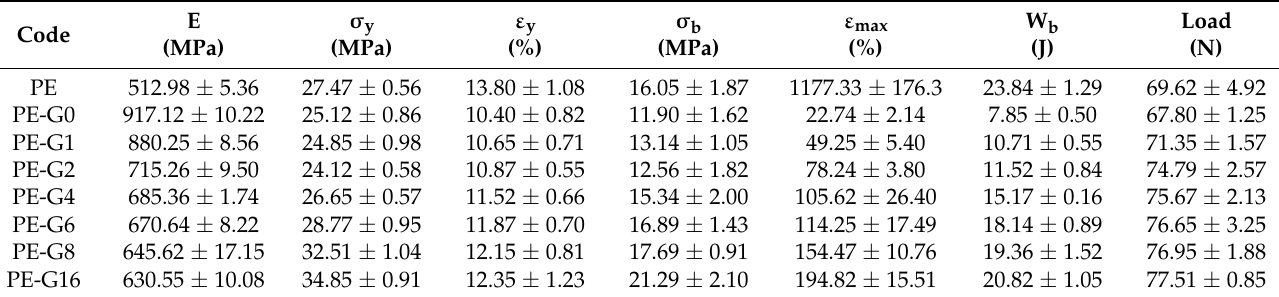
Table 2. Mechanical parameters obtained by the tensile test.